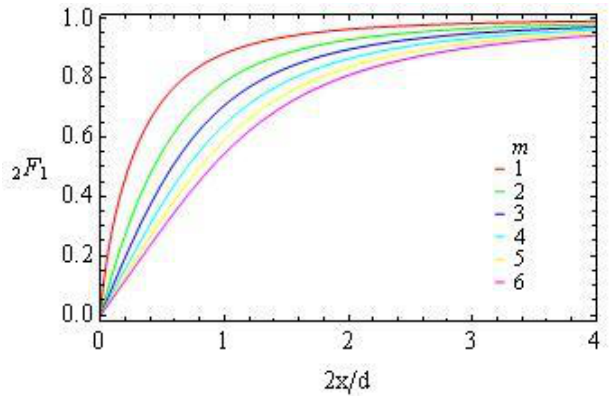
Figure 16. The Gauss hypergeometric functions